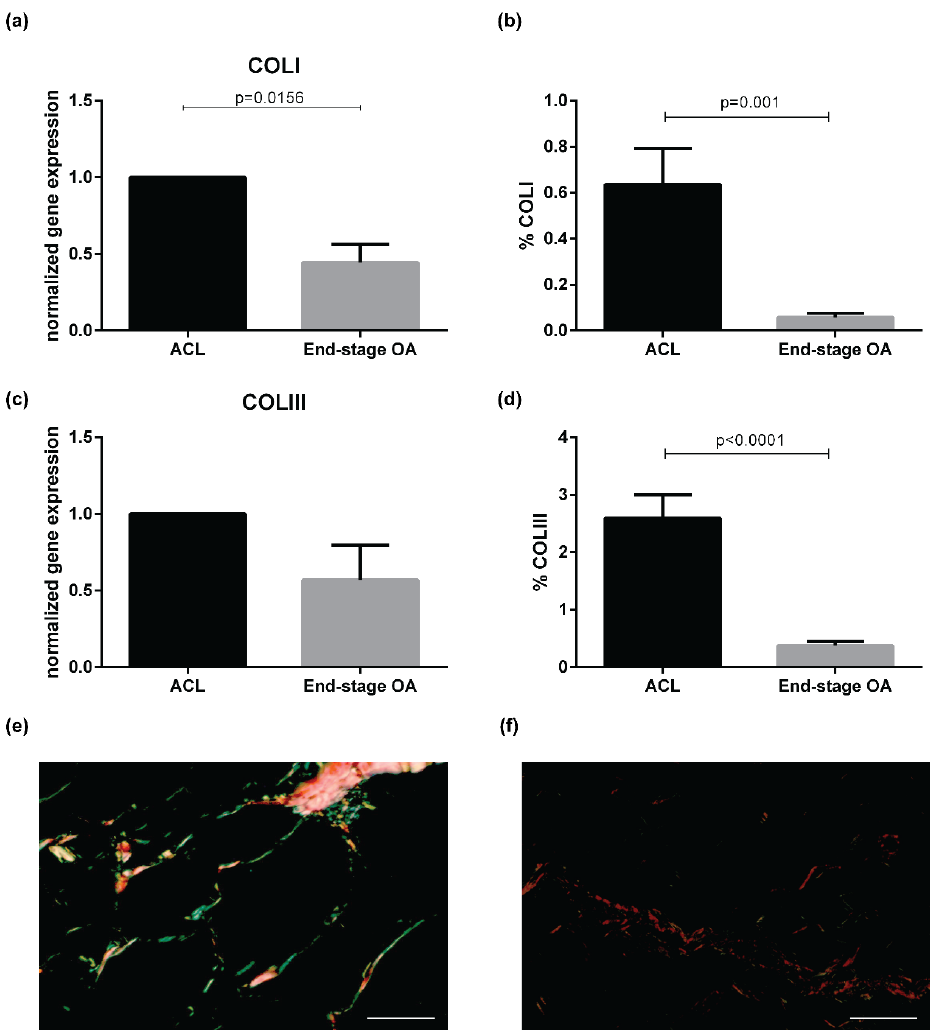
Figure 4. Extracellular matrix remodeling gene expression in ACL IFP ( n = 8) and end-stage OA IFP ( n = 8) and Sirius red evaluation. ( a ) COLI gene expression was higher in ACL IFP compared to end-stage OA. ( b ) COLI was higher in ACL IFP compared to end-stage OA evaluated by Sirius red. ( c ) COLIII gene expression was higher in ACL IFP compared to end-stage OA. ( d ) COLIII was higher in ACL IFP compared to end-stage OA evaluated by Sirius red. ( e ) Sirius red staining of ACL IFP (COLI (thick fibers) = yellow-red birefringence; COLIII (thin fibers = green birefringence). ( f ) Sirius red staining of end-stage OA IFP (COLI (thick fibers) = yellow-red birefringence; COLIII (Thin fibers = green birefringence). Scale bars = 50 μm. COLI = collagen type I; COLIII = collagen type 3; ACL = anterior cruciate ligament; IFP = infrapatellar fat pad; OA = osteoarthritis.